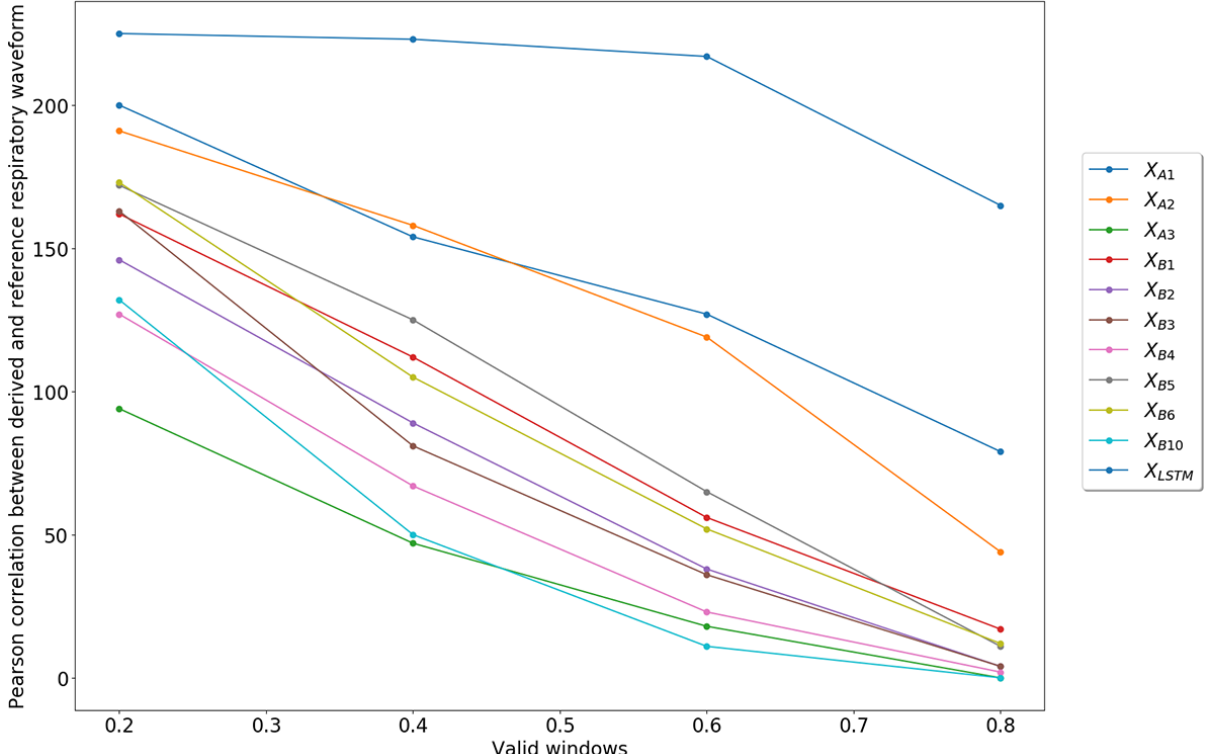
Figure 3. Number of valid windows as a function of increasing Pearson correlation coefficients between derived and reference respiratory waveforms in 0.2 increments. For an explanation of the variables please refer to Table